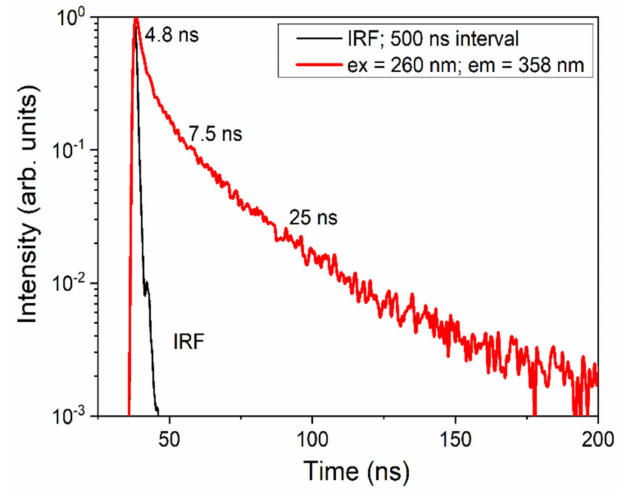
Figure 5. Decay kinetics of the UV luminescence for the undoped LiMgPO 4 crystal under excitation at 260 nm in the vicinity of the respective excitation band. The instrumental response function (IRF) is also